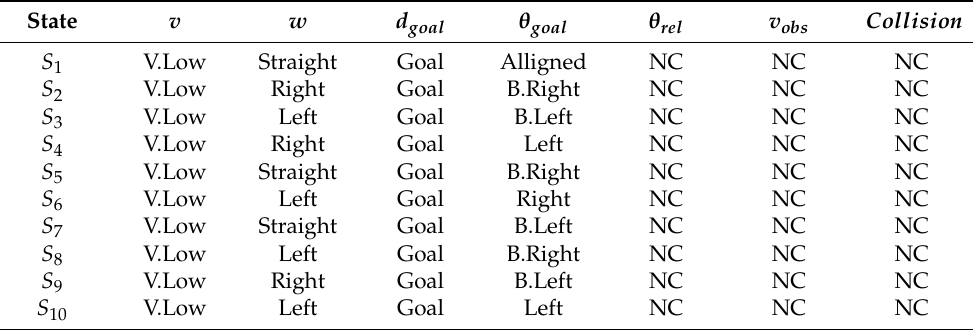
Table 4. The 10 most valuable states after training the RL-DOVS-A system. V.Low represents the state Very low; B.Left and B.Right represent the states Behind left and Behind right respectively; NC represents the state No